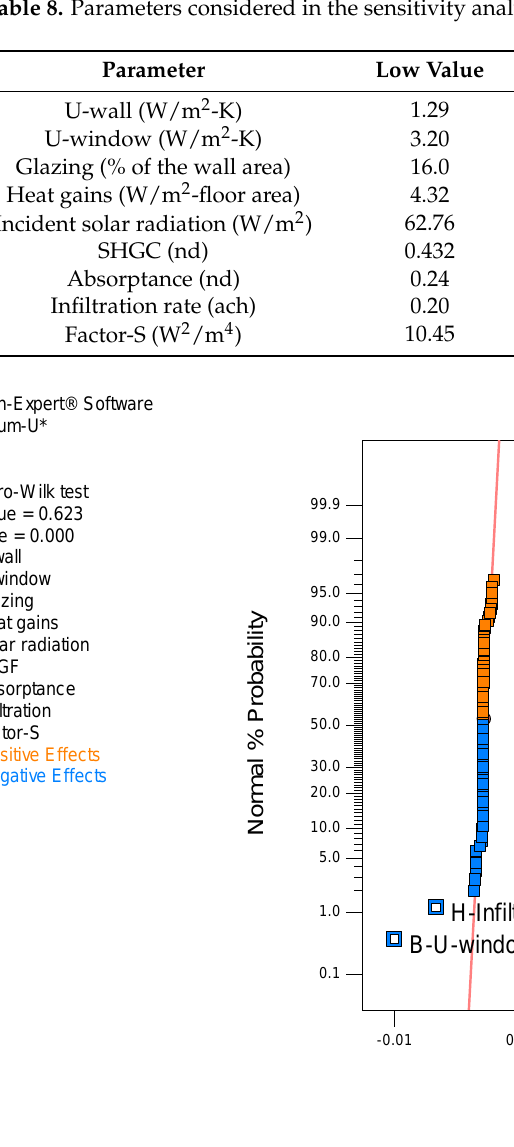
Table 8. Parameters considered in the sensitivity analysis and respective ranges of variation.